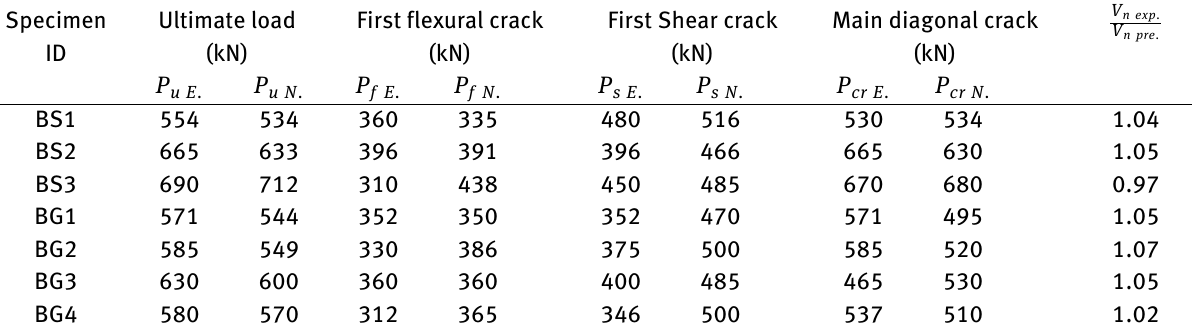
Table 13: Summary of experimental and numerical results loads (ABAQUS 6.13) Specimen